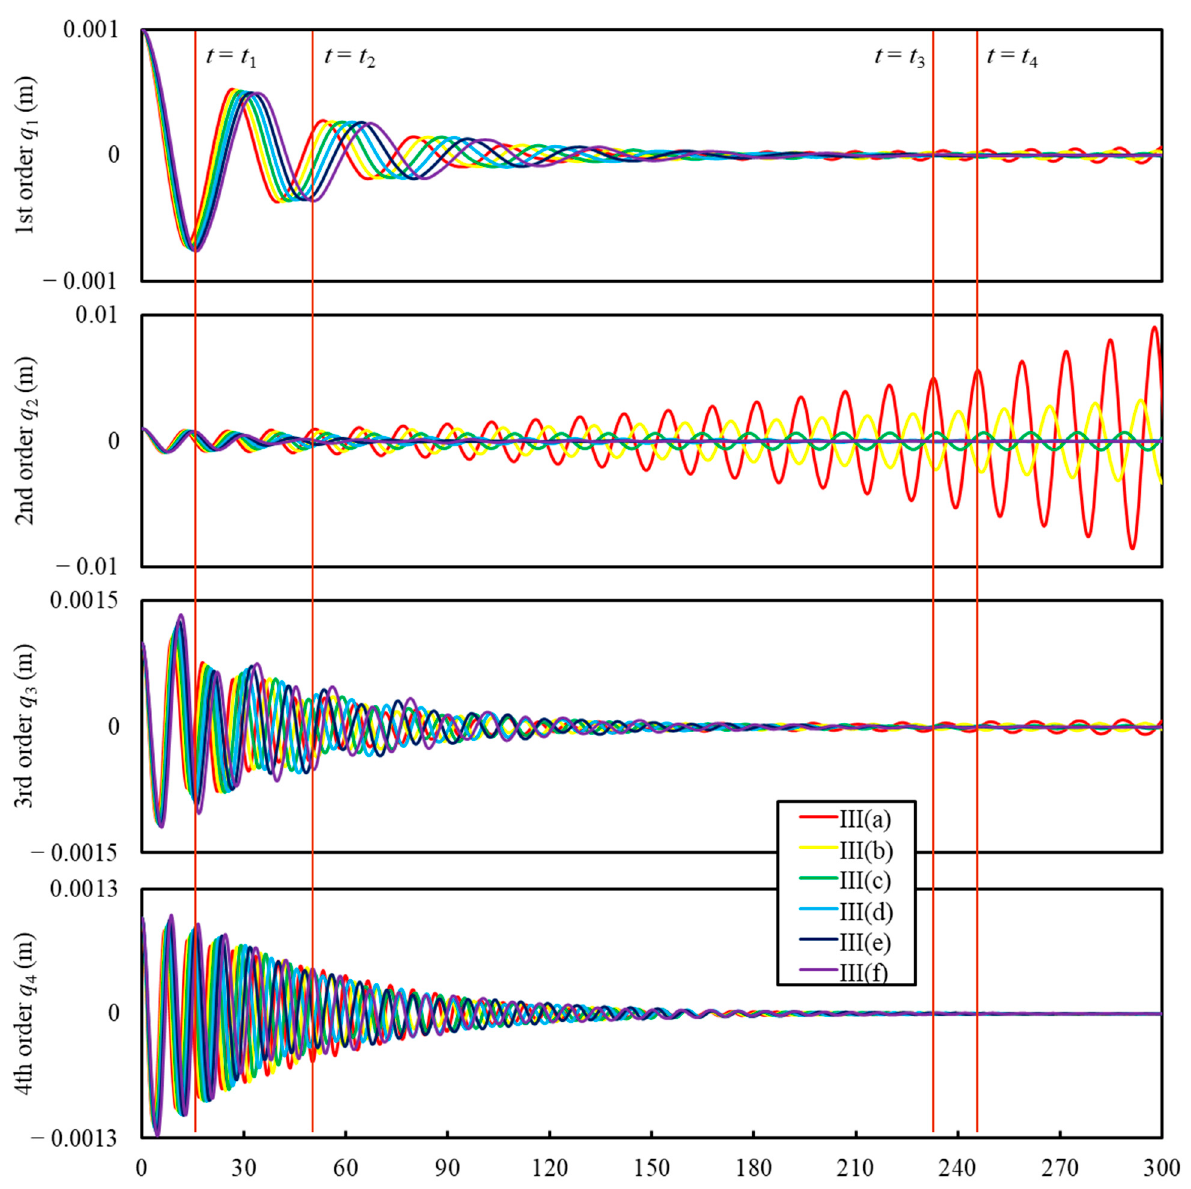
Figure 14. The responses of the first 4 modes of cases with different wet-weight coefficients.